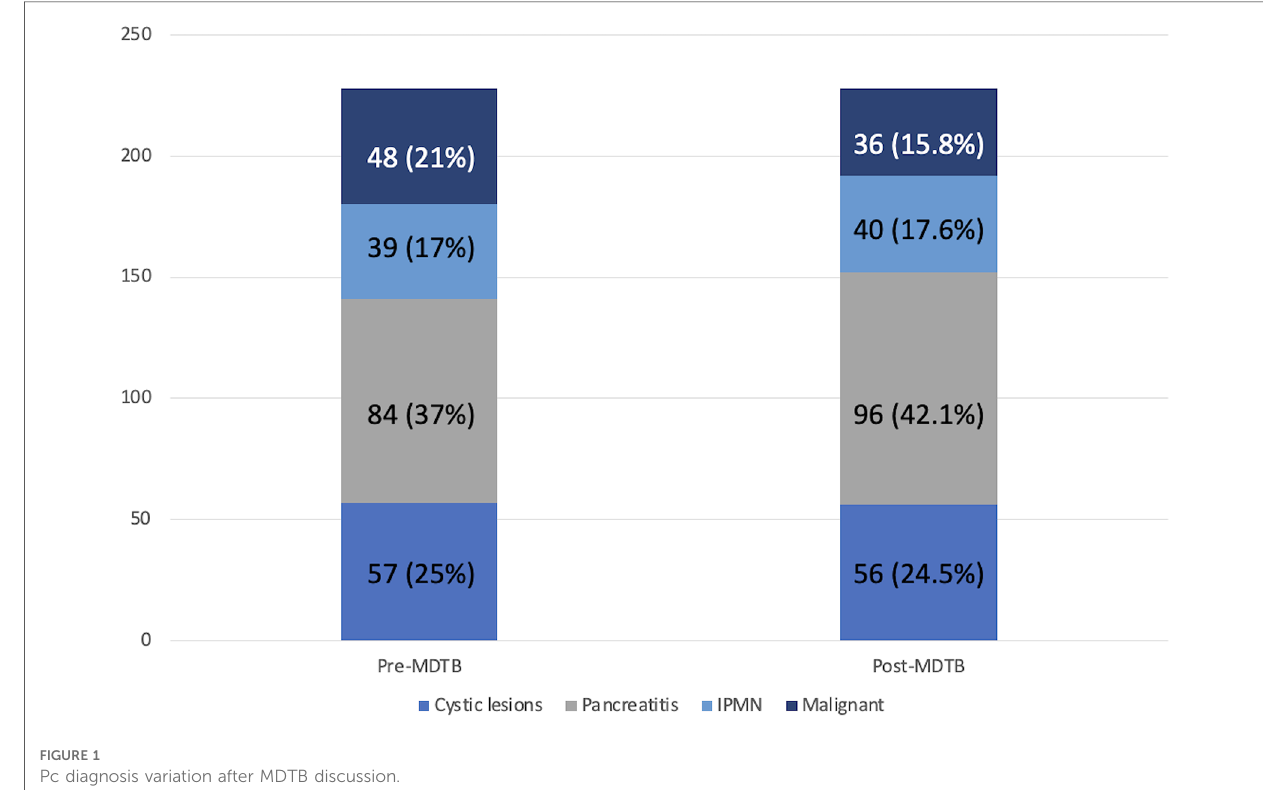
FIGURE 1 Pc diagnosis variation after MDTB discussion.